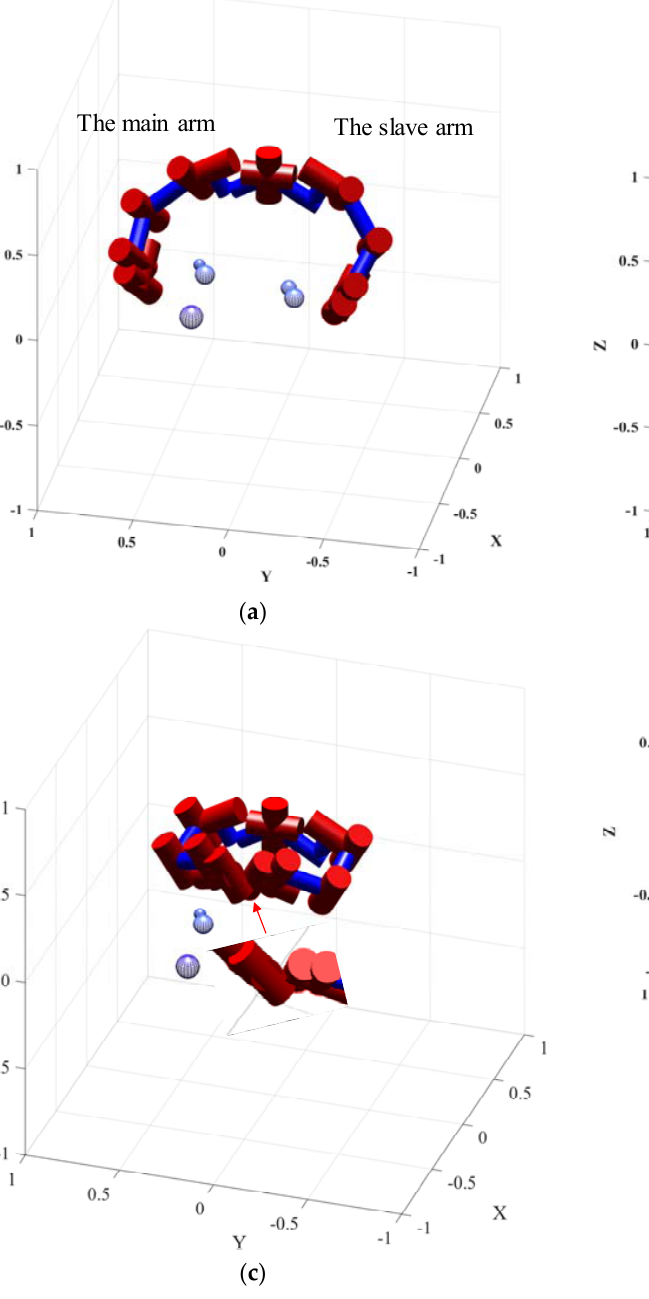
Figure 8. Motion state decomposition without obstacle avoidance path planning: ( a ) initial state; ( b ) motion state 1, collide with the environment; ( c ) motion state 2, self-collision; ( d ) side view of final state.